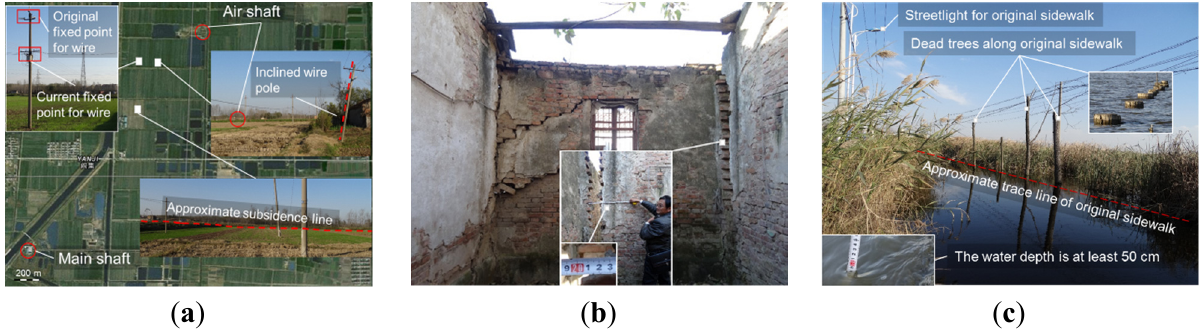
Figure 1. Example of surface subsidence problems induced by underground mining. ( a ) Surface subsidence around Zhangji Colliery in Xuzhou, at latitude and longitude of 34.3667 and 117.0229, respectively; the mining depth is more than 900 metres; ( b ) Building damage associated with Zhangji Colliery in Xuzhou, at latitude and longitude of 34.3846 and 117.0315, respectively; ( c ) Waterlogging around the Pangzhuang Colliery in Xuzhou, at latitude and longitude of 34.3566 and 117.0766, respectively. (Xiaowei